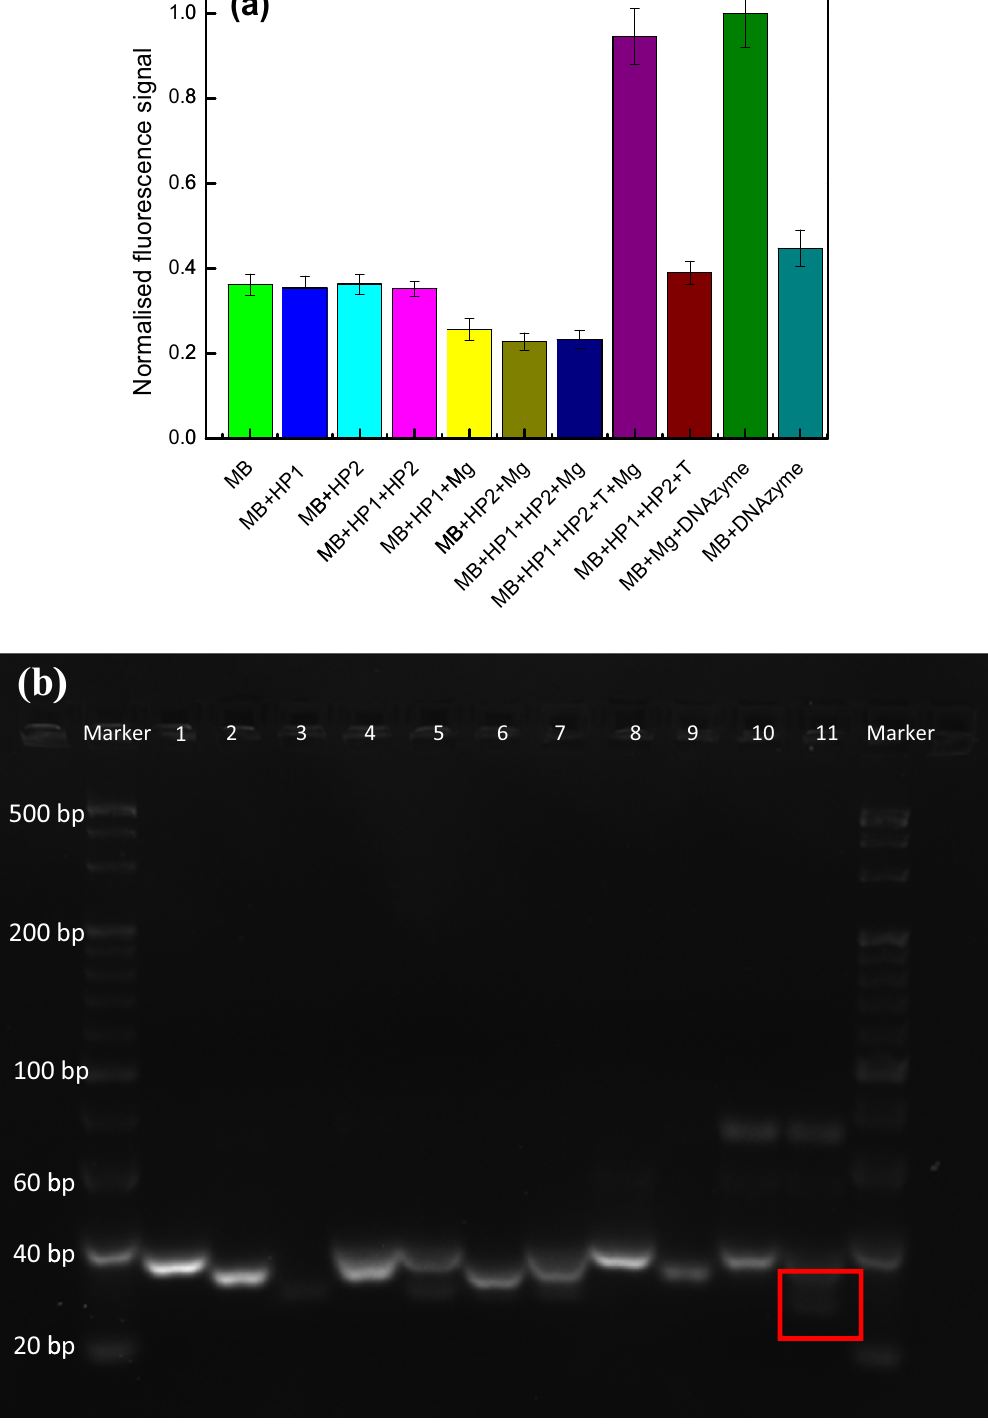
Figure 2: Validation of the detection system. ( a ) Fluorescence intensities of the sensing system under di ff erent conditions. The error bars represent the standard error of three independent measurements. ( b ) PAGE image of the sensing system. Lane 1: HP1; Lane 2: HP2; Lane 3: MB; Lane 4: HP1 + HP2; Lane 5: MB + HP1; Lane 6: MB + HP2; Lane 7: MB + HP1 + HP2; Lane 8: HP1 + T; Lane 9: HP2 + T; Lane 10: HP1 + HP2 + T; Lane 11: MB + HP1 + HP2 + T. The concentrations of target DNA ( T ) , HP1, HP2, and MB were 1